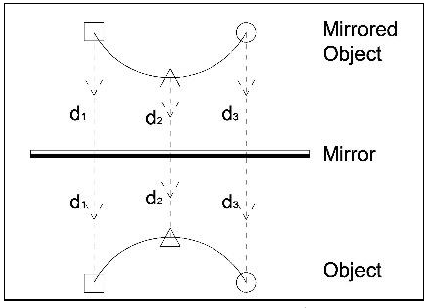
Figure 2: Translation transformation (Thomaidis, 2014)